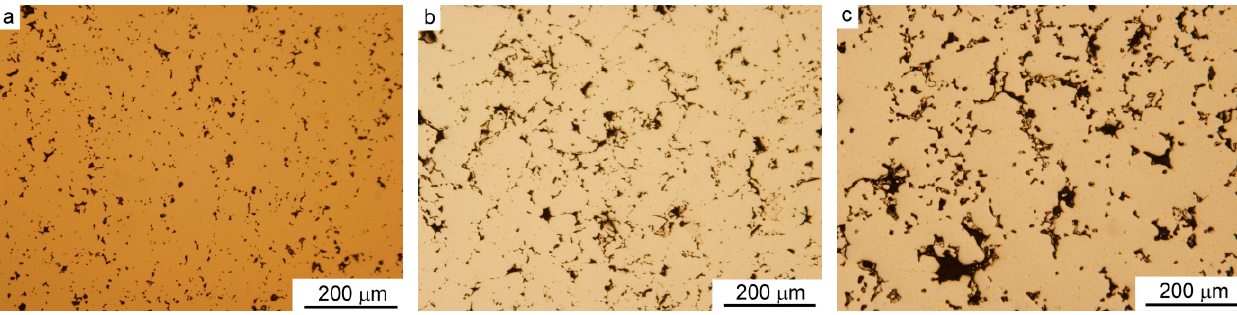
Figure 4. Pores in sintered materials: ( a ) Fe, ( b ) Fe-3.2 wt.% Cu, and ( c ) Fe-8.0 wt.% Cu, LM.